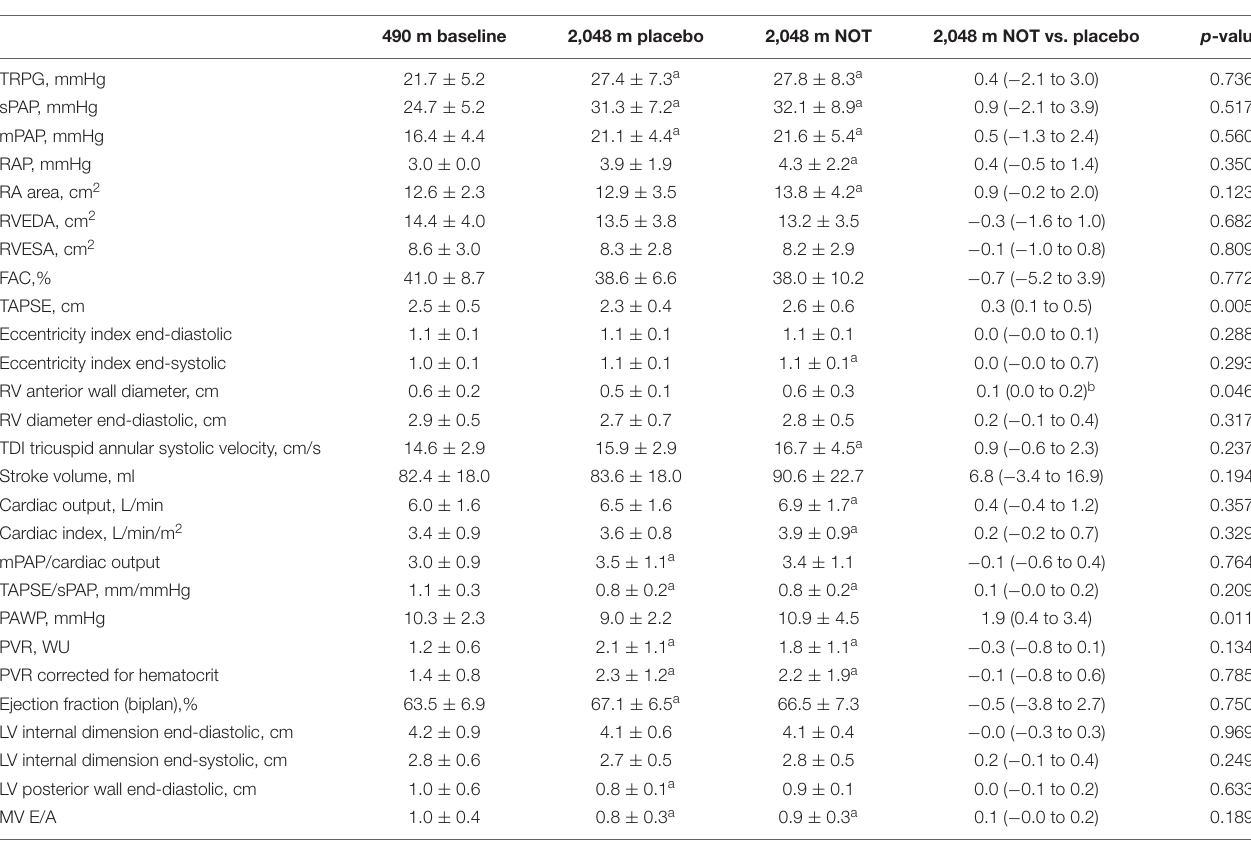
TABLE 3 | Echocardiographic